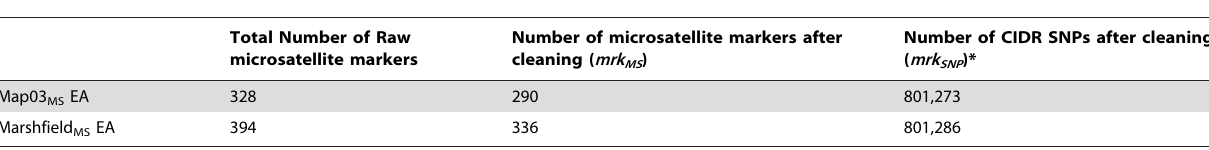
Table 6. Summary of microsatellite and SNP markers in EA group before and after cleaning.